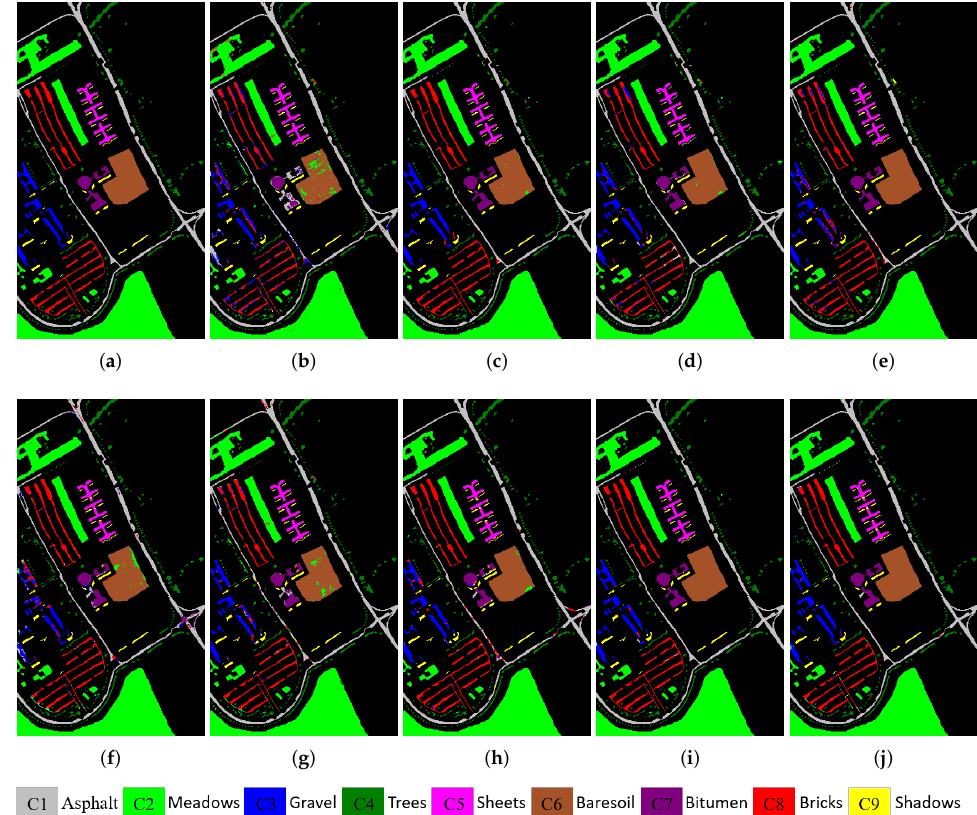
Figure 7. Map of the classification results from all approaches on UP. ( a ) Ground truth. ( b ) CD-